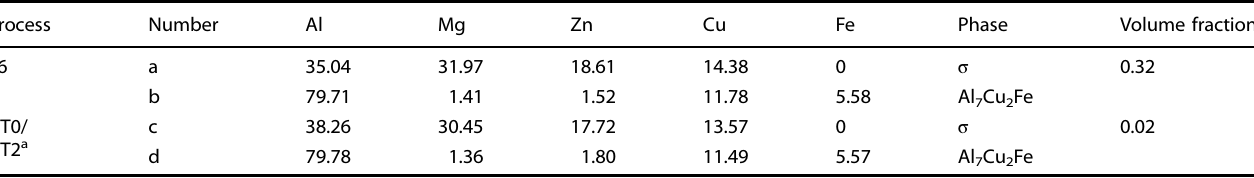
a The solution treatment parameters of HT0 and HT2 are the same.